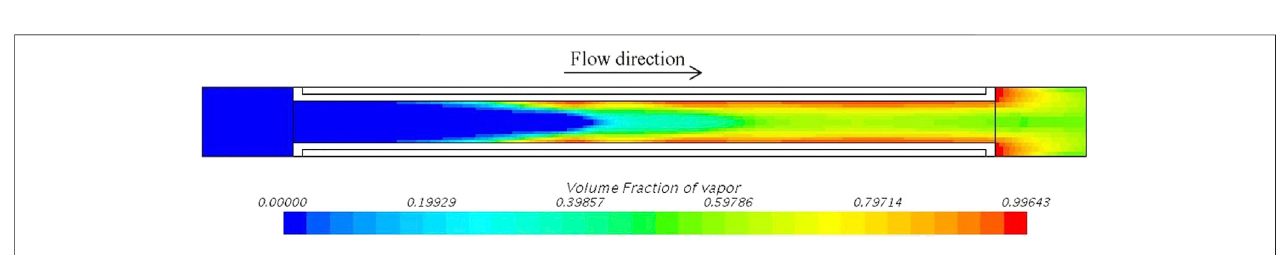
FIGURE 9 | Temperature of coolant, cladding and fuel with different power